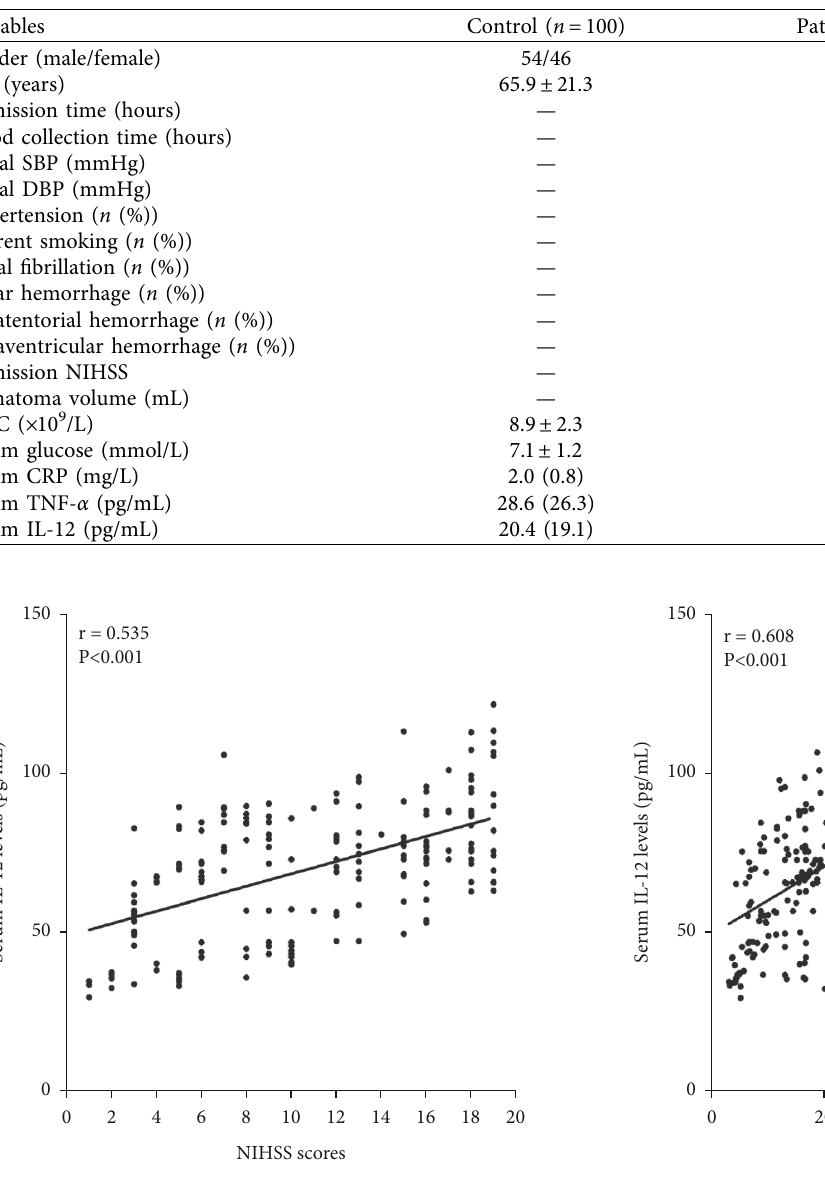
Table 1: Demographics and serum IL-12 levels in controls and patients.